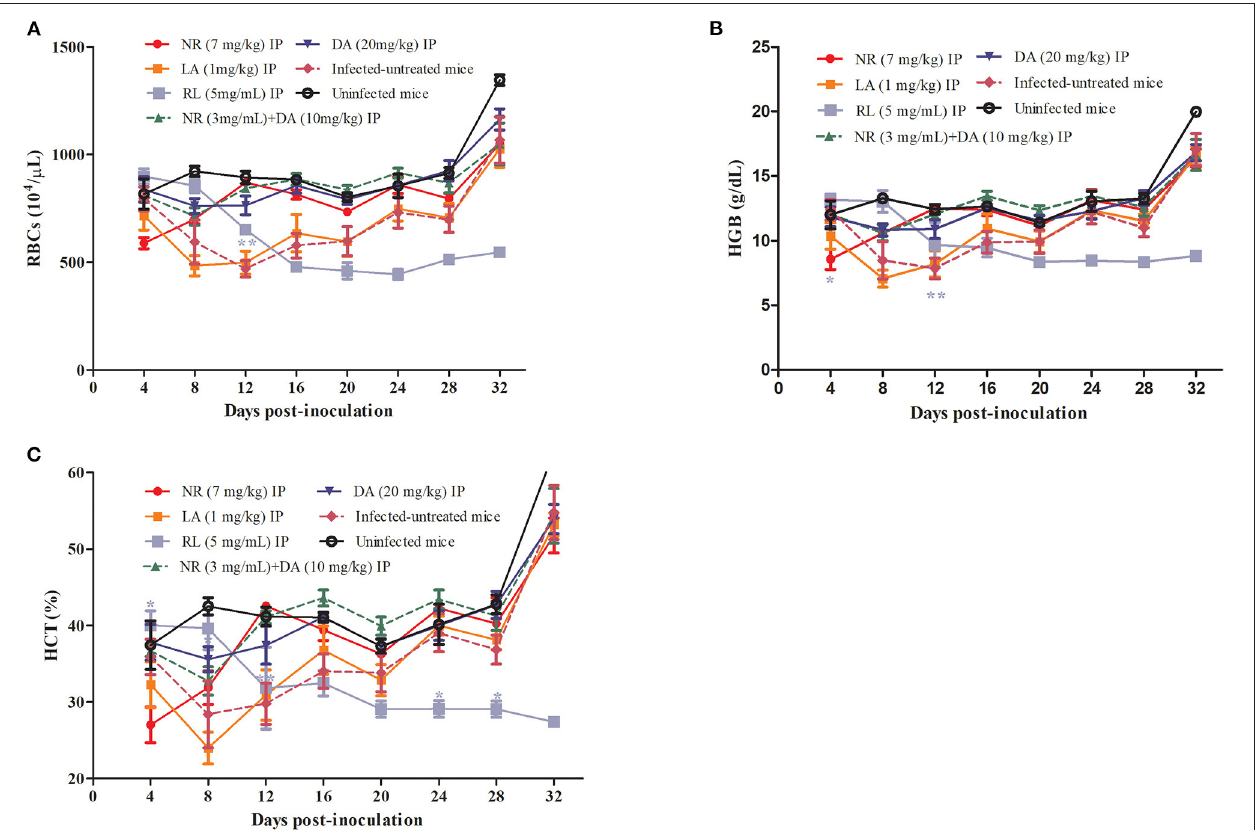
FIGURE 5 | RL, NR, and LA in treatment of anemia associated with Babesia. The hematological parameters of RBCs (A) , HGB (B) , HCT (C) .